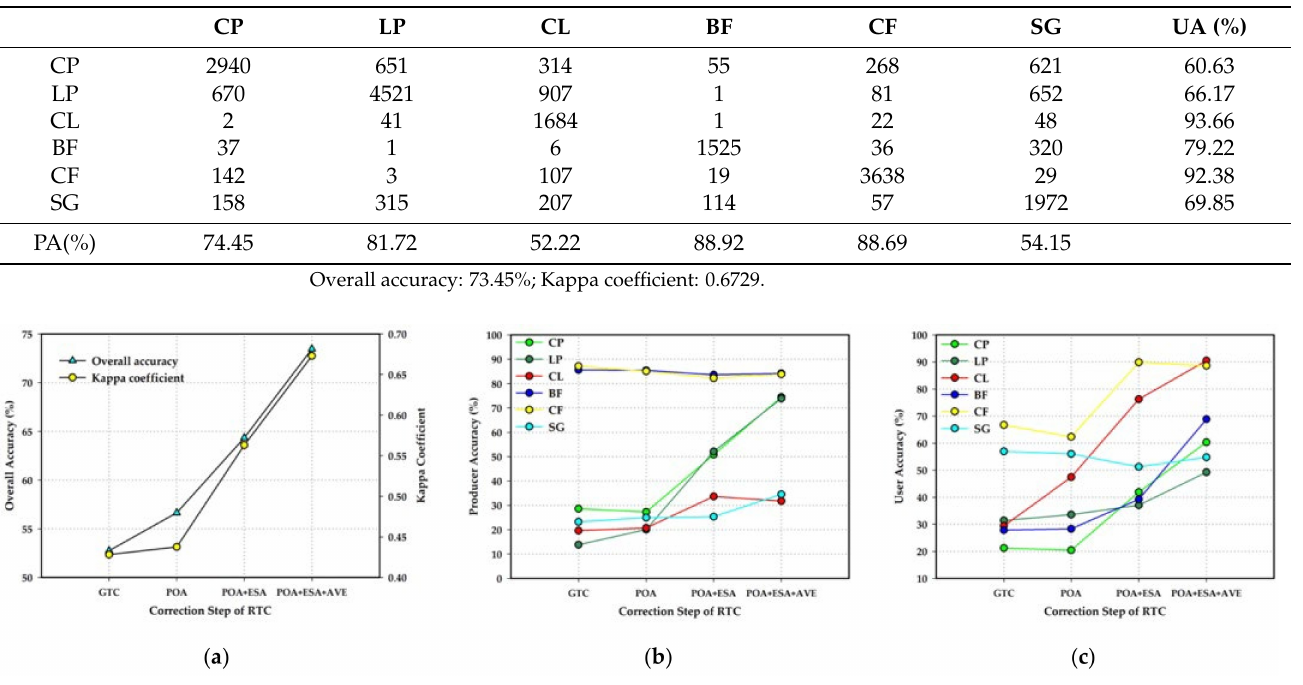
Table 4. Confusion matrix of the classification results of PolSAR data after POA + ESA +AVE correction.